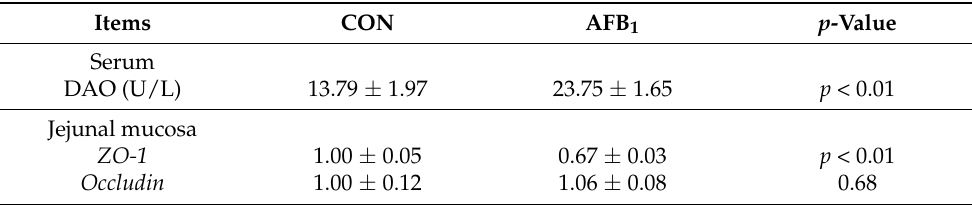
Table 8. Effects of AFB 1 on serum DAO activity and the relative mRNA expressions of barrier junction-related genes in jejunal